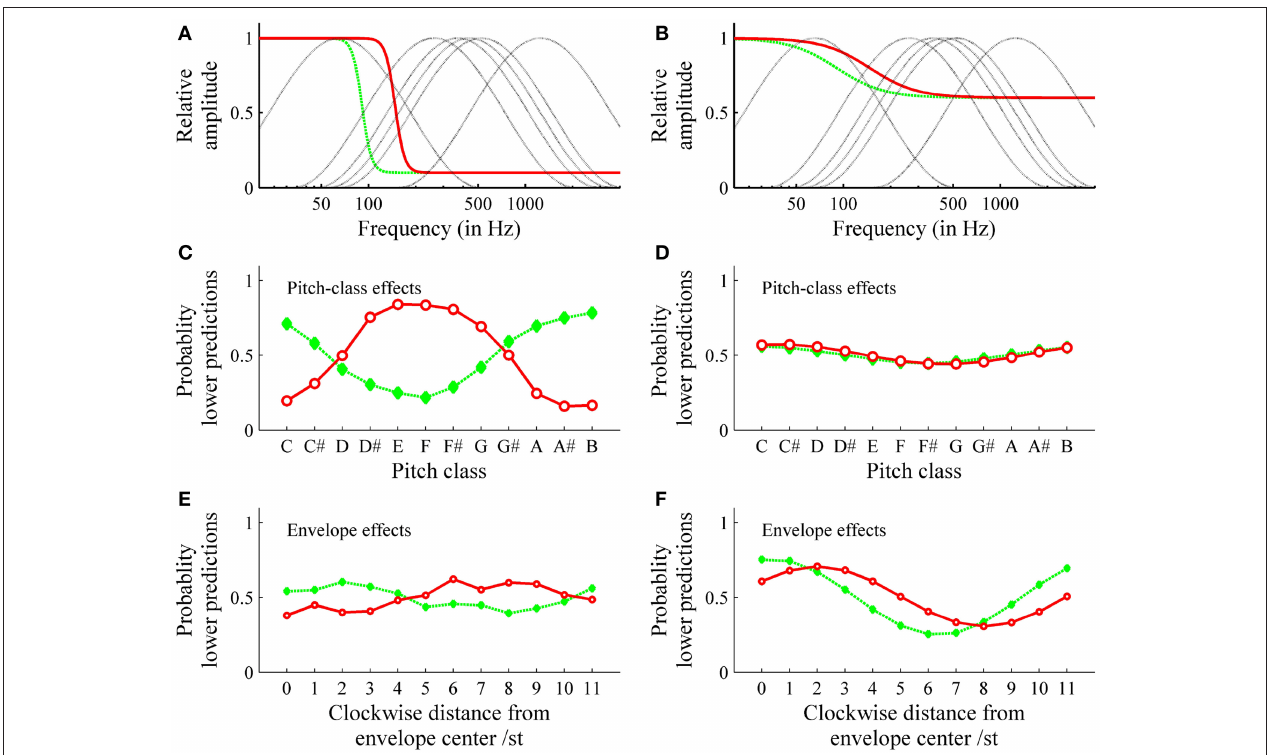
FIGURE 13 | Simulation of pitch class (C,D) and envelope effects (E,F) : The steep (nearly vertical) threshold functions (A) cause pronounced pitch class (C) and small envelope effects (E) ; shifting the threshold function on the frequency axis causes the shift in pitch class effects pattern in (C) (solid red or dashed green threshold functions lead to solid or dashed effects, respectively); the flat (nearly horizontal) threshold functions (B) cause small pitch class effects (D) and pronounced envelope effects (F) ; shifting the threshold function on the frequency axis causes the shift in envelope effects pattern (F) . These simulations were performed for Shepard tones under the spectral envelopes used in the experiment (dotted line in A , B